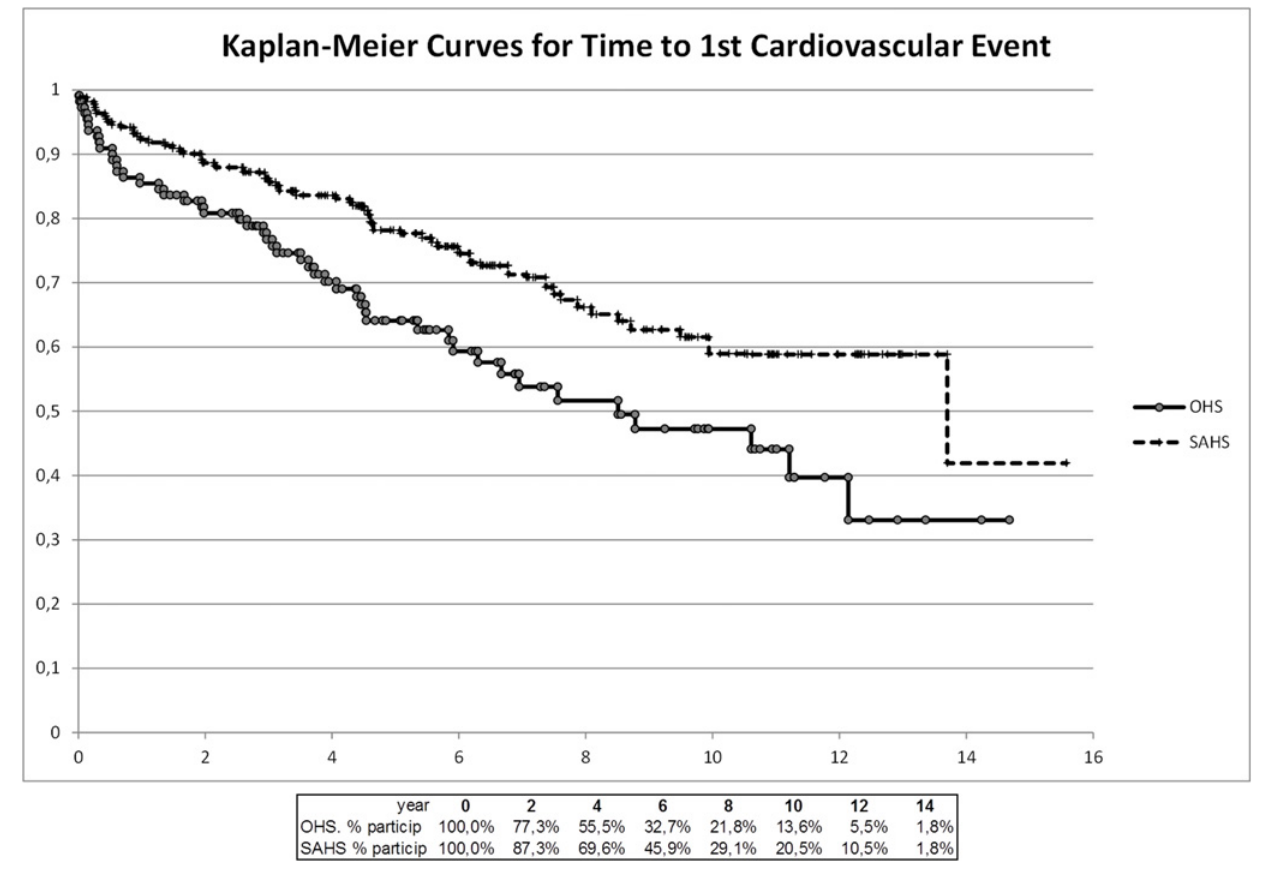
Fig 3. Kaplan Meier curves for time to first cardiovascular